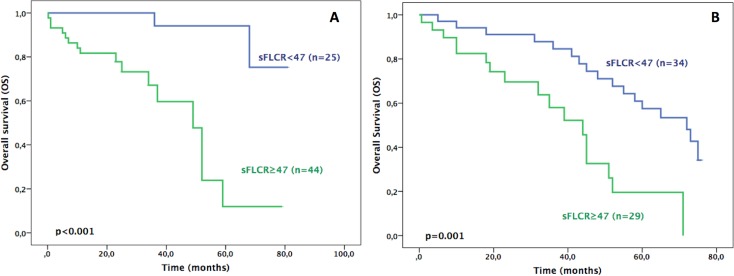
Prognostic value of sFLCR regarding the treatment scheme (A) Overall Survival (OS) of patients under treatment with novel agents (n = 69) stratified by sFLCR. (B) Overall Survival (OS) of patients under treatment with traditional agents (n = 63) stratified by sFLCR.